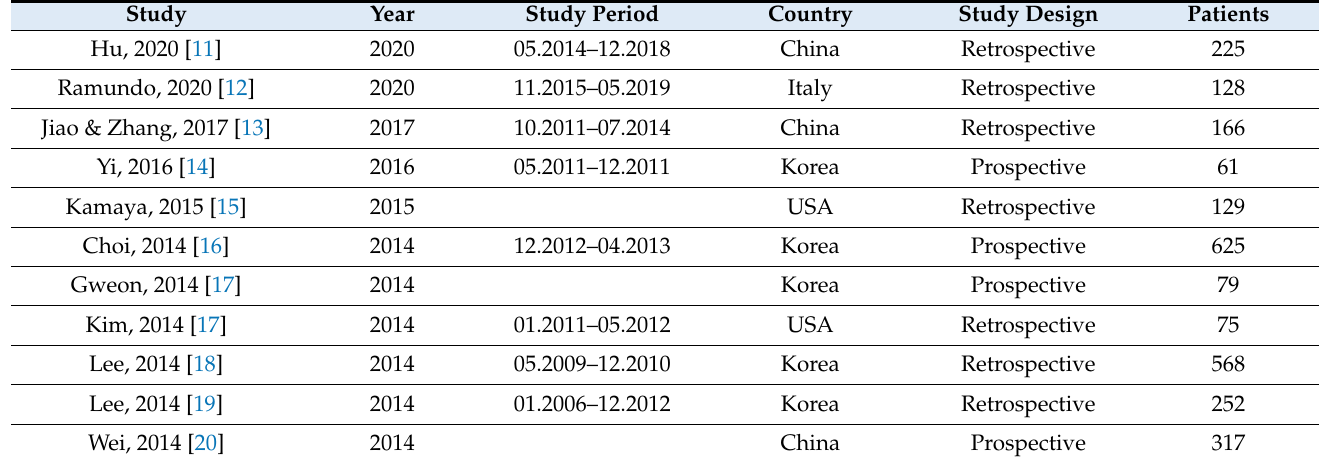
Table 1. Characteristics of the studies included. The study period is reported as months.year.